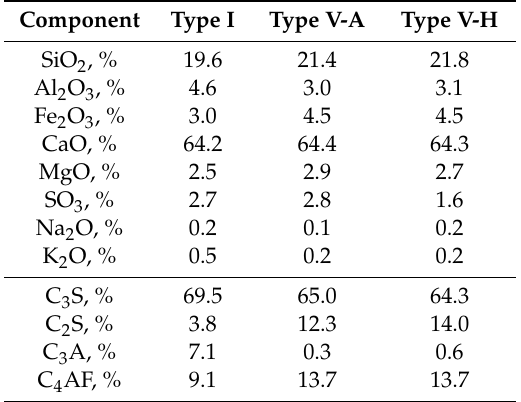
Table 1. Chemical composition of cement based on X-ray fluorescence (XRF)